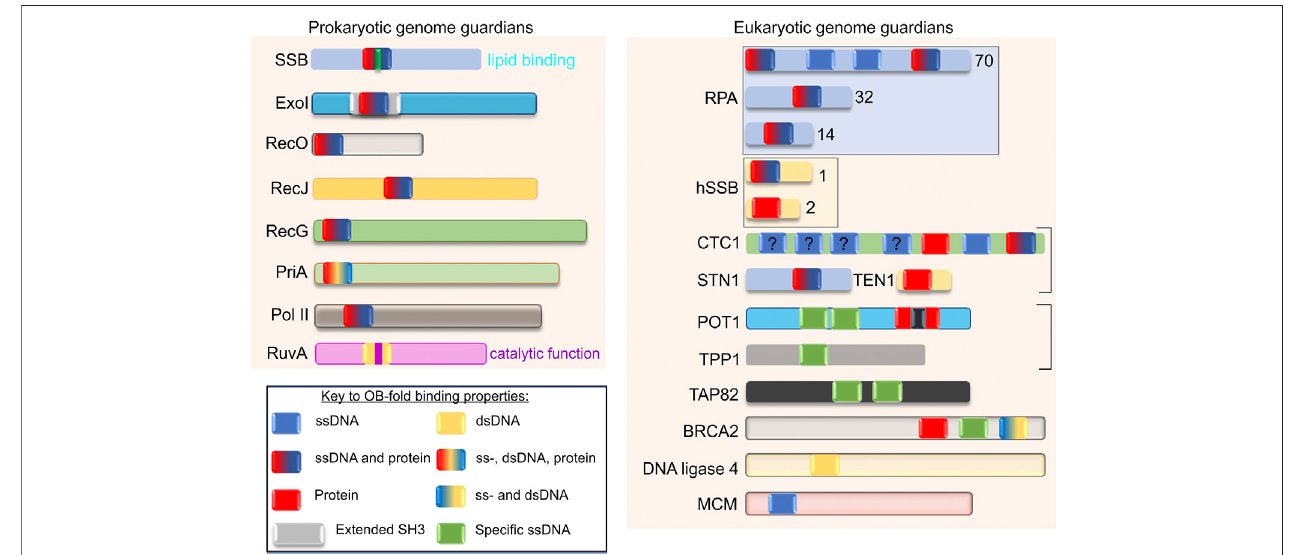
FIGURE3| OB-foldgenomeguardiansareubiquitous.Schematicsofrepresentativefamilymembersfrombothprokaryotesandeukaryotesareshown.The fi gure is adapted from reference (Flynn and Zou, 2010). Each OB-fold is drawn the same size for simplicity and the different colours within each domain re fl ect the binding or substrate preferences ascribed to each protein. For Exonuclease I, the OB-fold is embedded within an extended SH3 domain (Breyer and Matthews, 2000). Family members are presented in different colors for clarity. The OB-folds of SSB, RuvA and POT1 have an additional coloured bar to indicate lipid binding, catalytic activity, and interruption by a Holliday Junction Resolvase domain, respectively. The “ ? ” indicates an OB-fold of unknown function. The boxes indicate these OB-fold proteinsexistinacomplex.Fordetailsonthefunctionofeachproteinthereaderisreferredto(Tye,1999;Bianco,2010;FlynnandZou,2010;SarbajnaandWest,2014; Wu et al., 2016; Nguyen et al., 2020; Bianco,